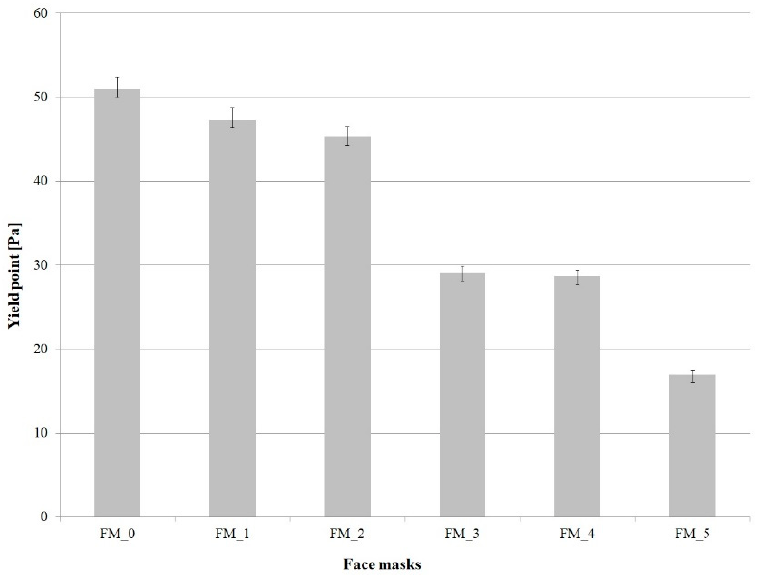
Figure 2. Yield point of face masks with different concentrations of Lonicera Caerulea Fruit Powder.